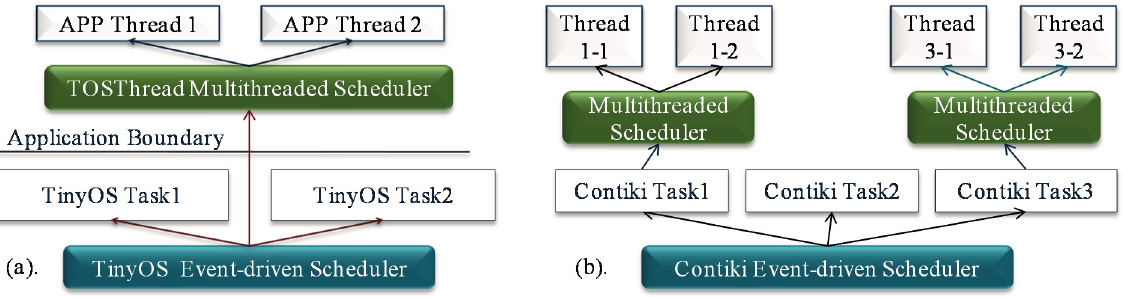
Figure 15. Multithreaded scheduling system in TinyOS ( a ) and Contiki ( b ). Different